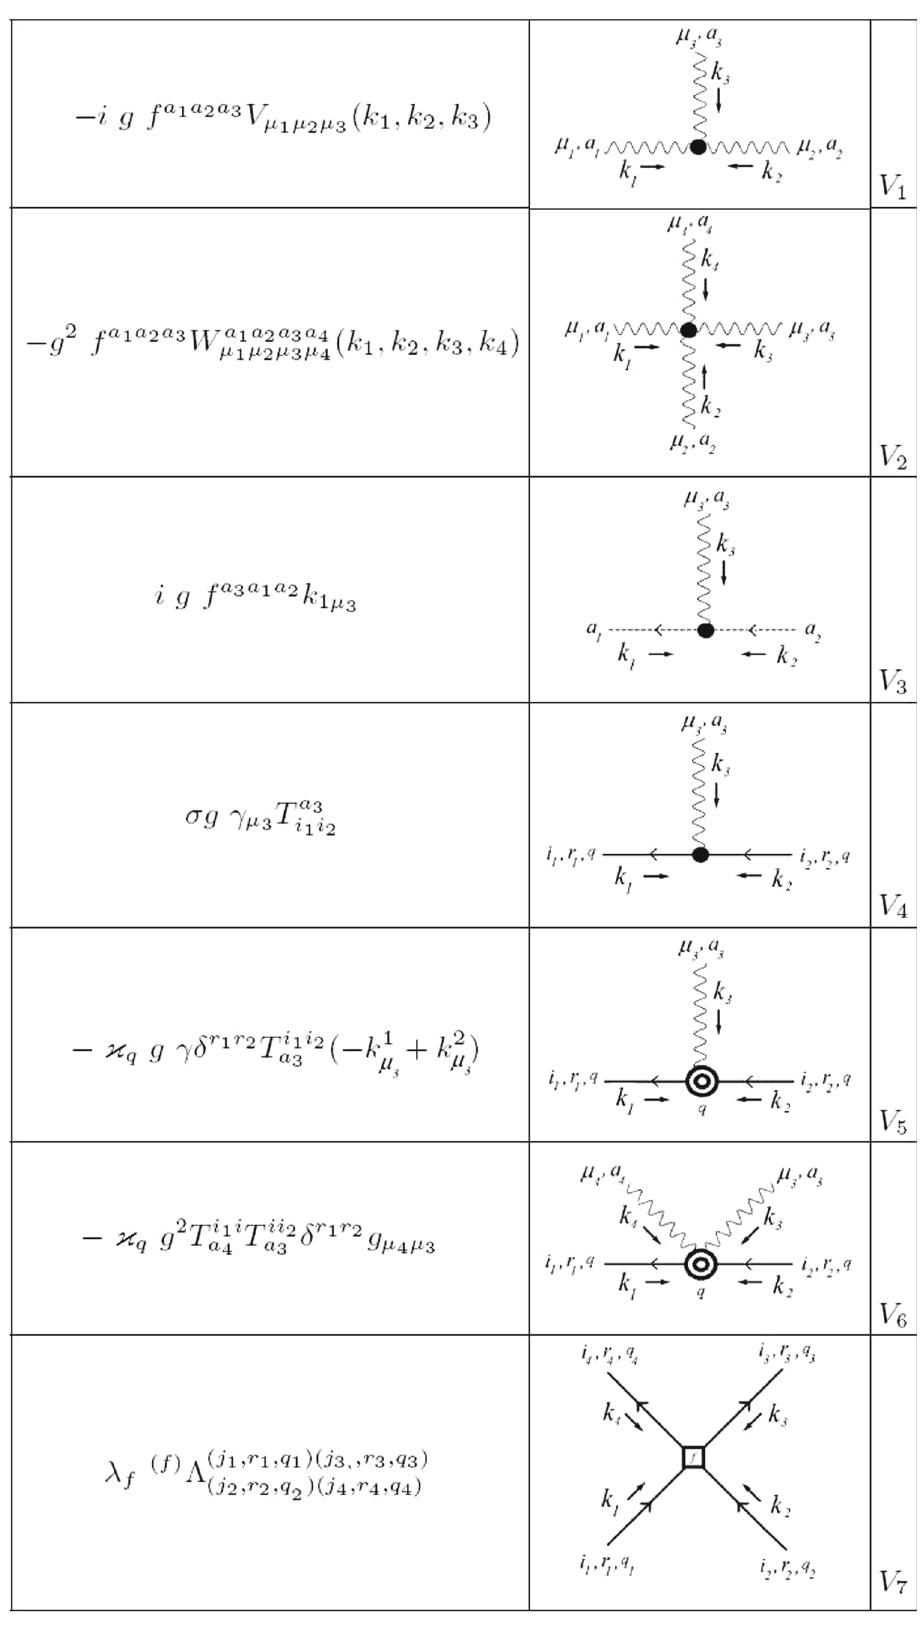
Fig. 4 The original vertices of the model in terms of the renormalized fields and